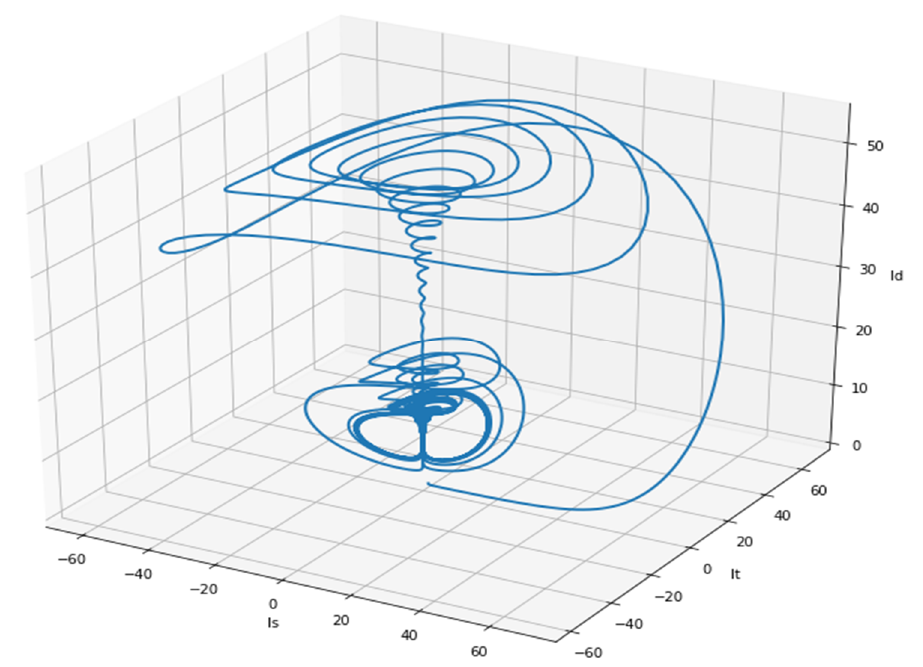
Figure 4. Change in the target parameters of the system at the basic values of the parameters of the Chen–Lee attractor. Source: finalized by the authors.